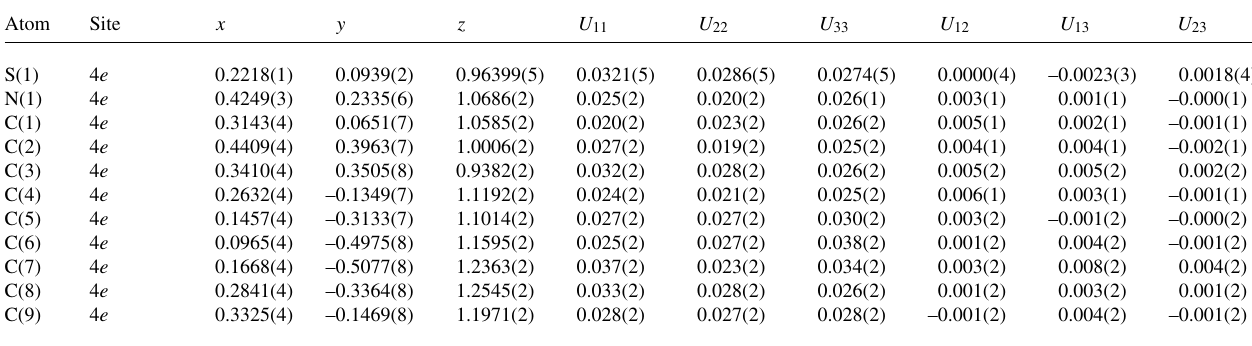
Table 3. Atomic coordinates and displacement parameters (in Å 2 )